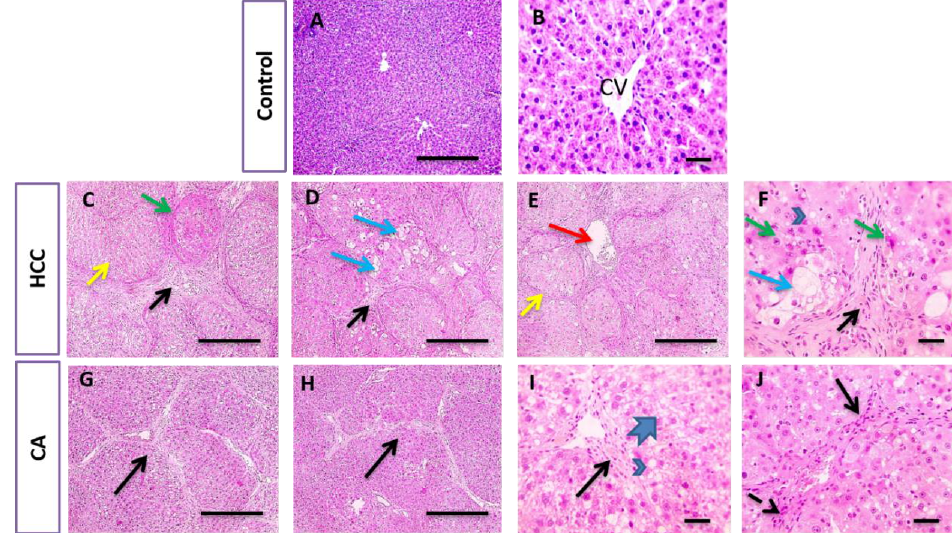
Figure 3. Histopathological examination of liver tissue in control, HCC and CA groups. H&E- stained liver sections. Hepatic sections show the normal arrangement of hepatic cords around central vein (CV) with the normal portal areas and sinusoids in control group. In contrast, hepatic sections from HCC group showing disrupted parenchymal structure due to extensive fibrosis (black arrows), scored six, associated with inflammatory cells infiltration that includes hemosiderin laden macrophages, congested blood vessels (red arrows). Hepatocytes are present in solid nodules (yellow arrows), lacking normal structures of hepatic lobules, suffered from microvascular degeneration (arrowheads) to ballooning degeneration (blue arrows) and necrosis (green arrows). Hepatic sections from CA group showing slightly improved hepatic parenchymal structure characterized by portal fibrosis (black arrows), scored four, associated with inflammatory cells infiltration (dashed arrows). Hepatocytes suffered from macrovascular degeneration (arrowheads) to hydropic degeneration (thick arrows). Ten rats in each group. Scale bar = 100 µm ( A , C – E , G , H ), Scale bar = 50 µm ( B , F , I , J ).